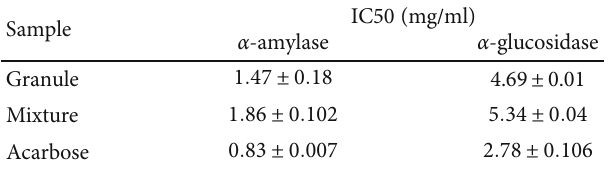
Table 5: IC50 values (mg/ml) of granules, mixture and acarbose. Sample